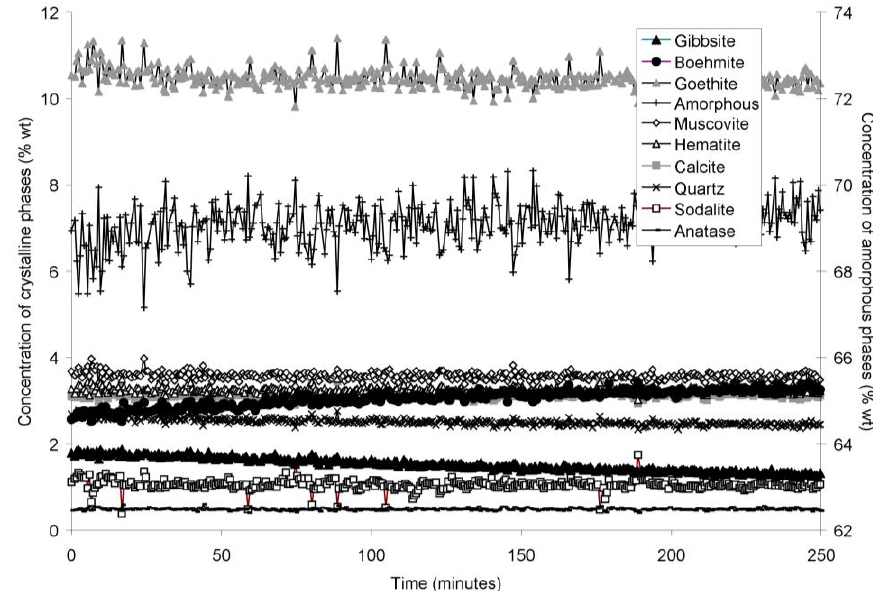
Figure 3. Concentration of crystalline and amorphous phases in bauxite residue slurry in capillary reaction vessels as a function of treatment time at 140 °C, as determined by Rietveld-based quantitative mineral analysis of X-ray diffractograms. Note that amorphous content is plotted on the secondary Y axis and represents contributions from X-ray amorphous minerals in bauxite residue, water in the slurry, and the fused silica capillary.